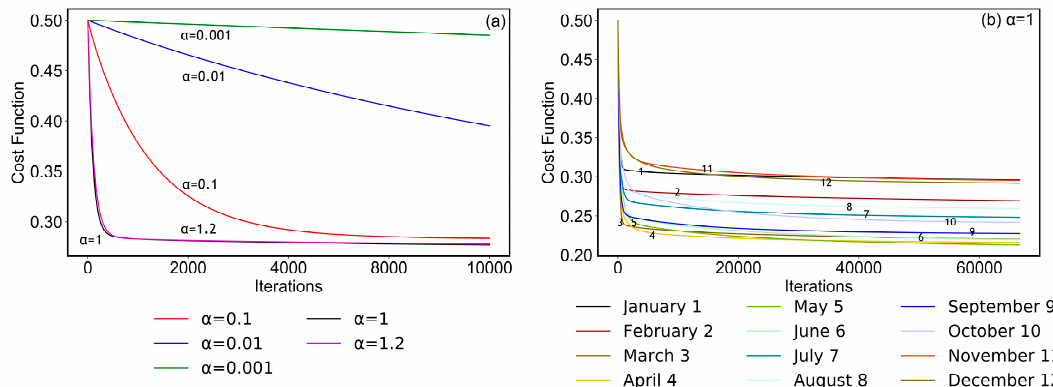
Figure 3. The relationship between cost function and iterations of batch gradient descent (BGD)-based polynomial regression. ( a ) The relationship between cost function and iterations under different learning rates. ( b ) The relationship between cost function and iterations in each month.